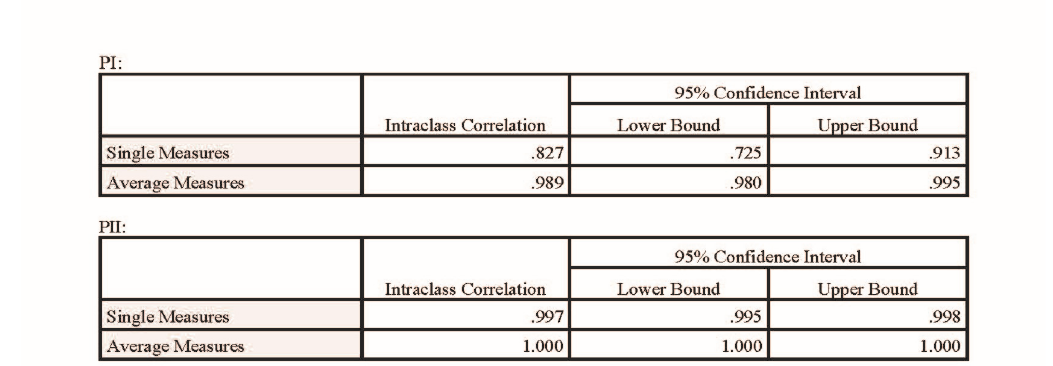
Figure 8. ICC values calculated for absolute agreement between blind